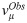
Metabolism of S. cerevisiae and E. coli data at various levels of overflow metabolism.We estimated the level of overflow metabolism as the normalized difference between observed vμObs and theoretical maximum vμMax biomass growth rates. (A) Various growth conditions of S. cerevisiae are represented by their observed rates of glucose exchange (uptake) and biomass growth. Δ correspond to mutated strains overproducing acetate. (B) Various growth conditions of E. coli.